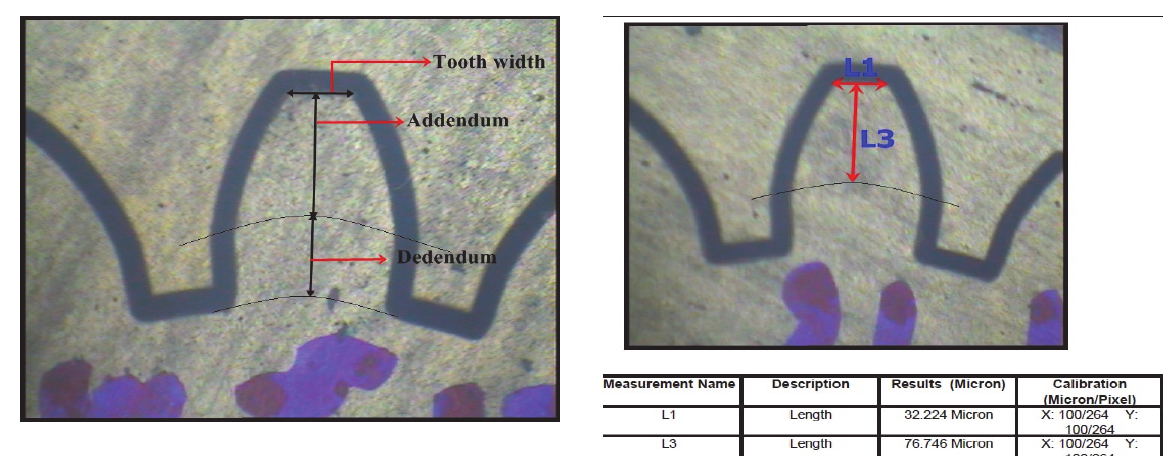
Fig. 9 Contour plot of RCC and Pulse on time and Pulse off time